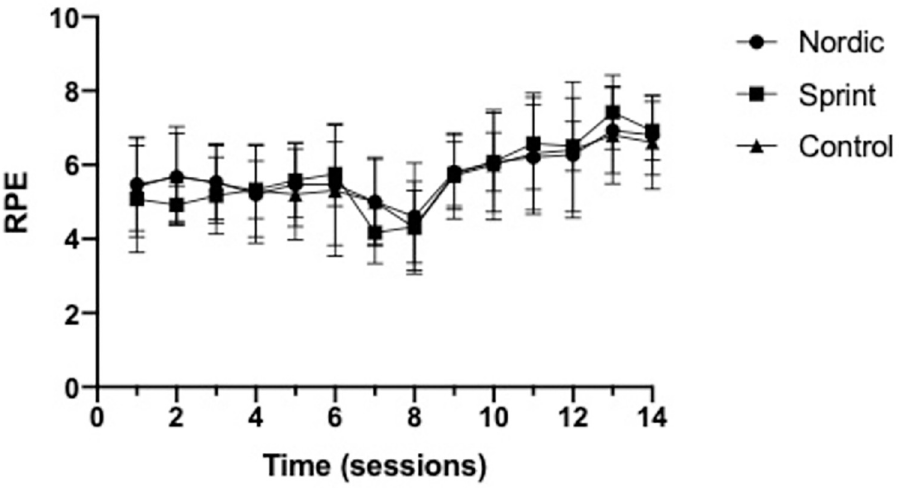
Fig 13. Mean ( ± 95%CI) Rating of perceived exertion measured using a numeric scale (1–10) for the Nordic hamstring exercise, Sprint and control groups.